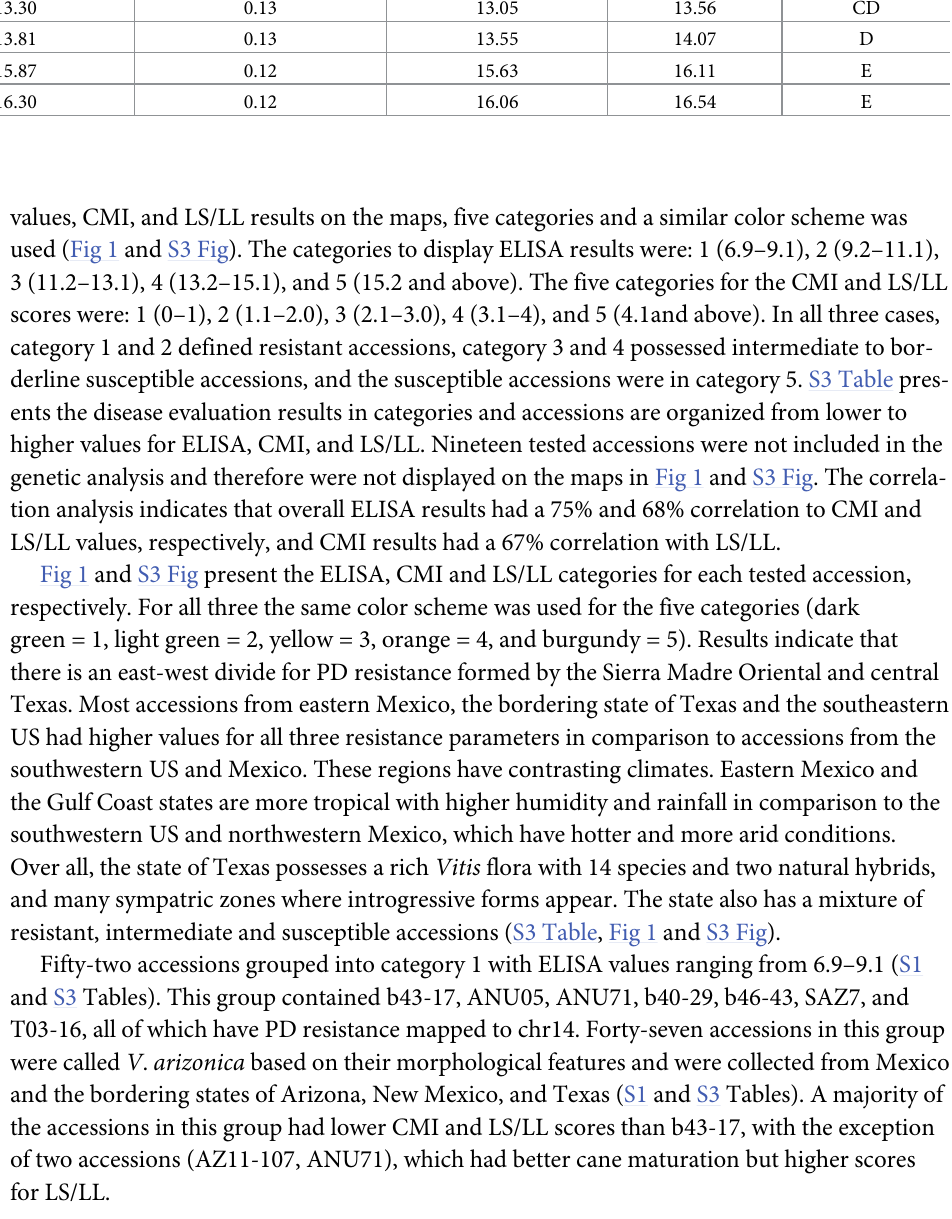
Table 2. a. Two-way ANOVA of the reference plants used as internal standards across 19 screens carried out from 2011 to 2018. Experiment take down date is abbre- viated as TD. Uninoculated Chardonnay was not included in the analysis. b. Least square means (LSM) comparisons of ELISA readings of bacterial levels using Tukey’s test with take down date and controls as variables. Results significantly separate the resistant, intermediate and susceptible reference plants. Confidence level (CL) were established at 95%. Uninoculated Chardonnay was not included in the analysis. Genetic